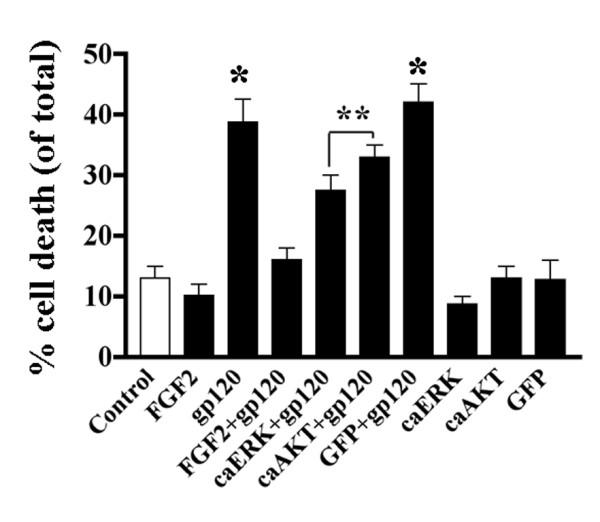
Gene transfer of constitutively active ERK and AKT protect cells from gp120 toxicity (A) After gene transfer of constitutively active (ca) ERK or ca AKT, HUVEC were exposed to gp120, FGF2 or a combination of both and cell viability was assayed via Trypan Blue Exclusion. Controls consisted of ca ERK, ca AKT and GFP gene transfer without further treatment. * indicates a significant difference from control. ** indicates a significant difference from *. * = P < 0.05 by One-Way ANOVA with post-hoc Dunnett's when compared to control. ** = P < 0.05 by One-Way ANOVA with post-hoc Tukey-Kramer when compared between experimental groups.